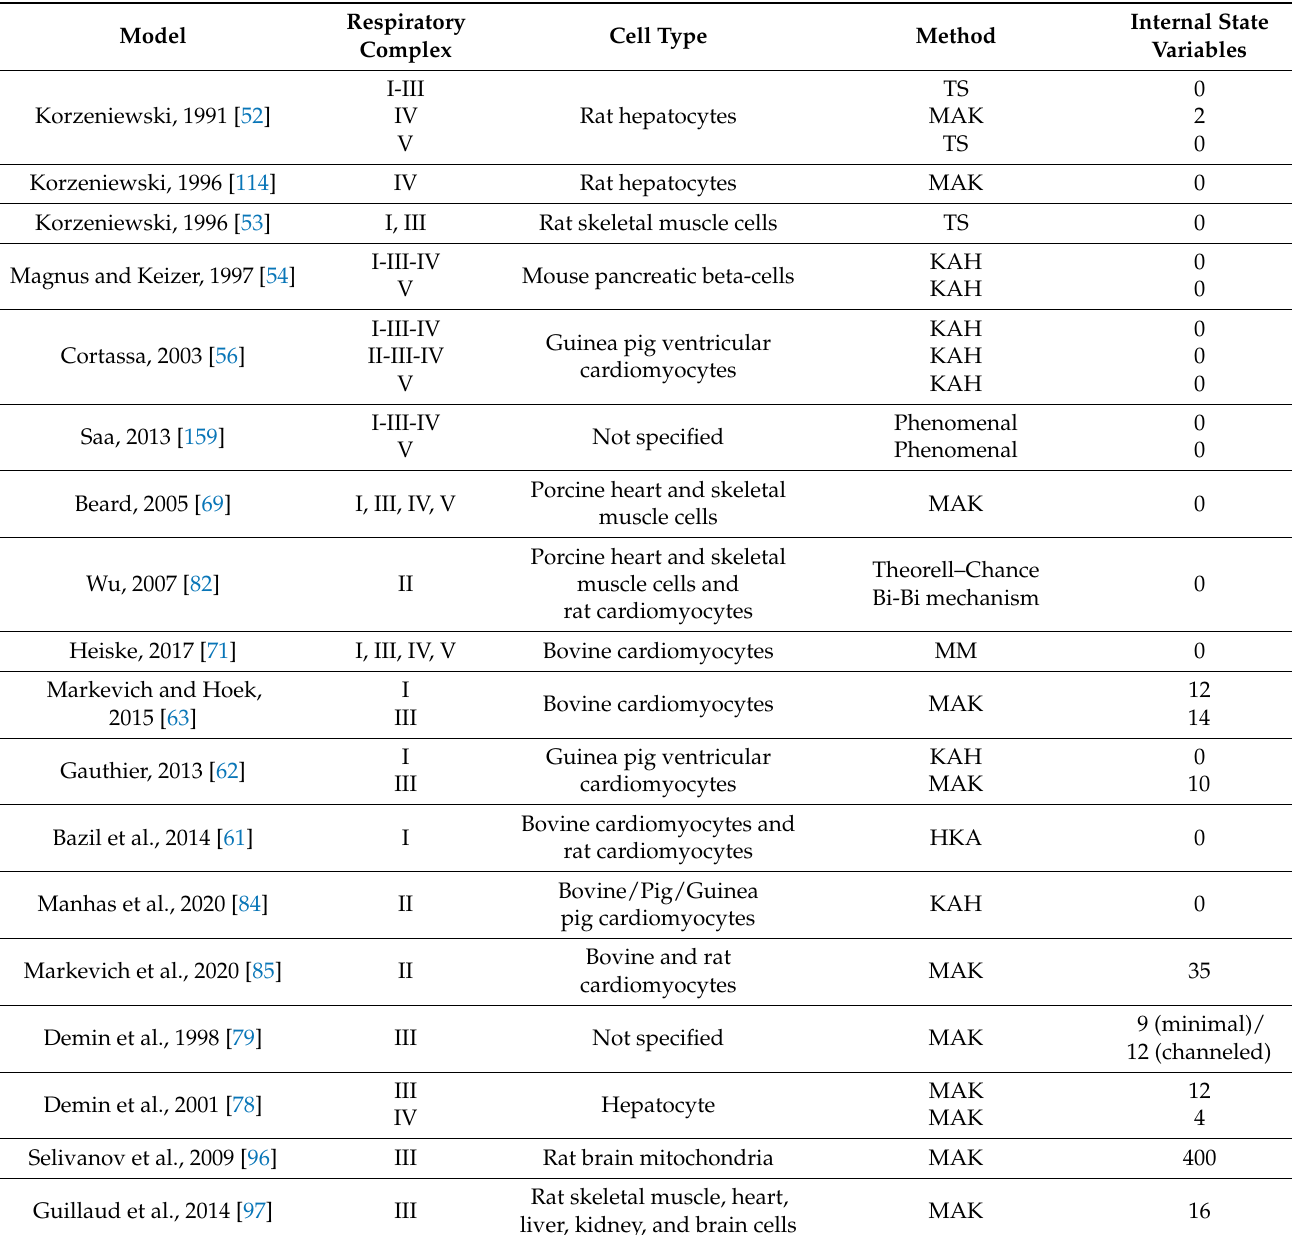
Table 1. List of published OXPHOS kinetic models reviewed in this